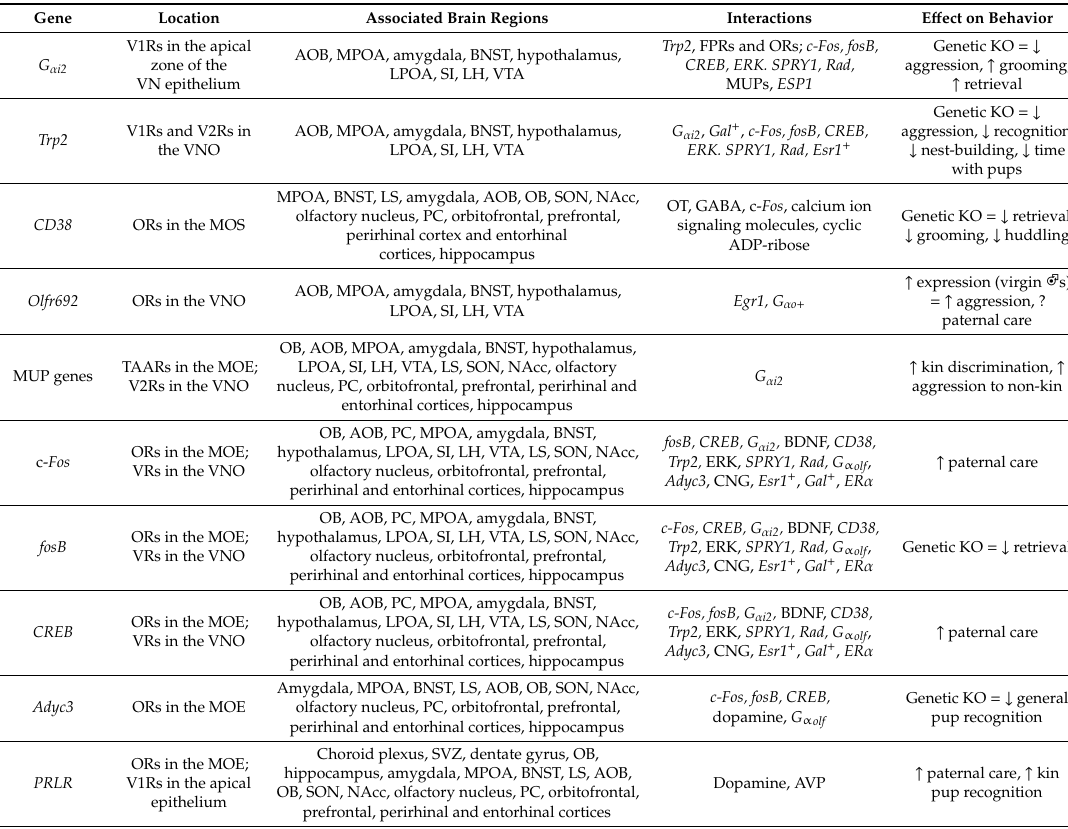
Table 1. Genes involved in the regulation and expression of paternal care behaviors in rodents, their theorized olfactory location, functioning associated brain regions and interactions with other genes, proteins or hormones (all references provided in text).